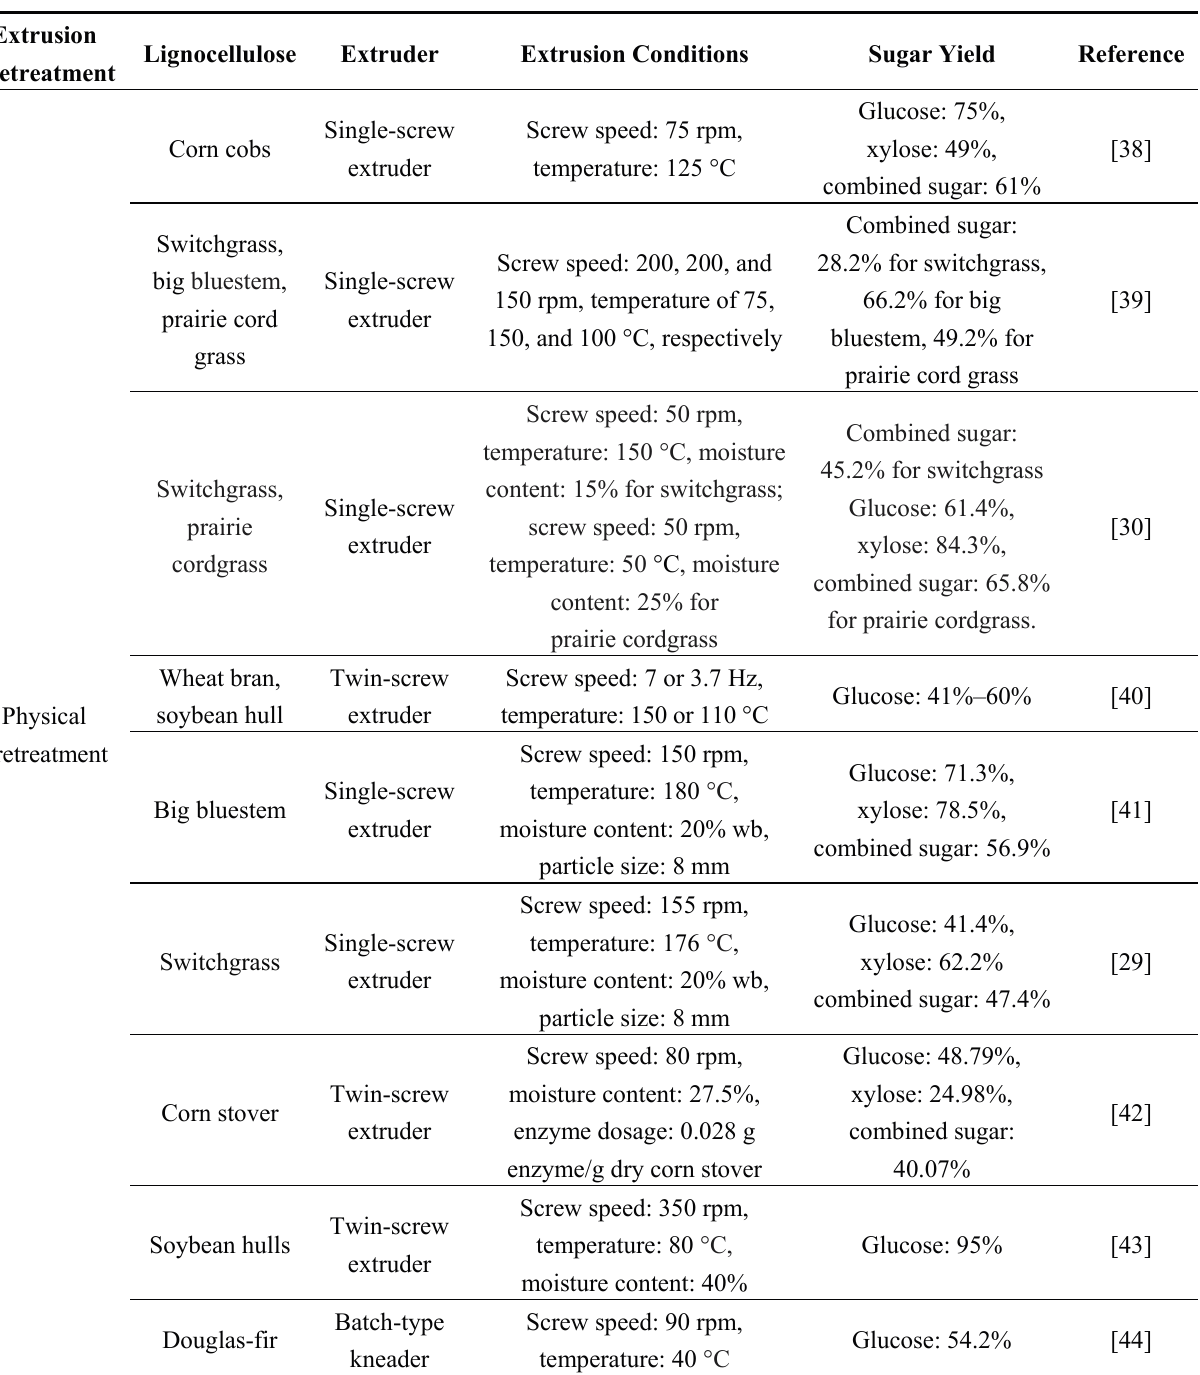
Table 1. Effects of different kinds of extrusion pretreatment of lignocellulosic biomass on sugar yields. Sugar yields presented in the table were produced from different feedstocks and achieved under different operating conditions, the basis of the percentage values can also vary between each study. The results show the typical range and are for reference purposes, detailed comparisons should only be drawn between highly similar conditions and